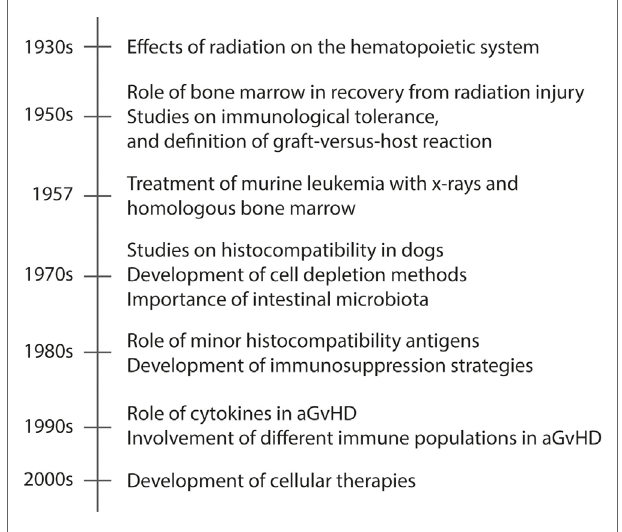
FiGURe 1 | A timeline presenting seminal events in animal models of aGvHD . Acute GvHD is caused by activated alloreactive donor T cells that directly cause tissue damage in target organs, such as skin and gut. The timeline shows the seminal findings in animal models that have led to the current understanding of aGvHD